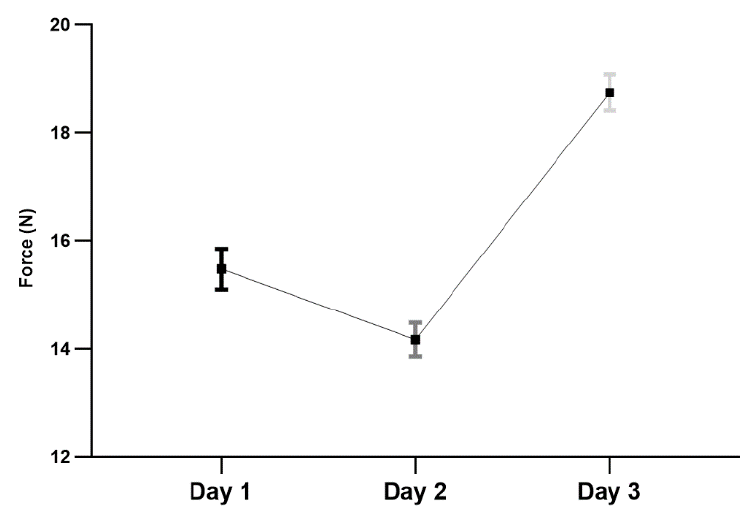
Figure 3. The least-squares means (±SEM) of MNT (N) over three alternate days. The values between all days were significantly different from each other ( p < 0.01 for Day 1 vs. Day 2, p < 0.0001 for Day 1 vs. Day 3, p < 0.0001 for Day 2 vs. Day 3).